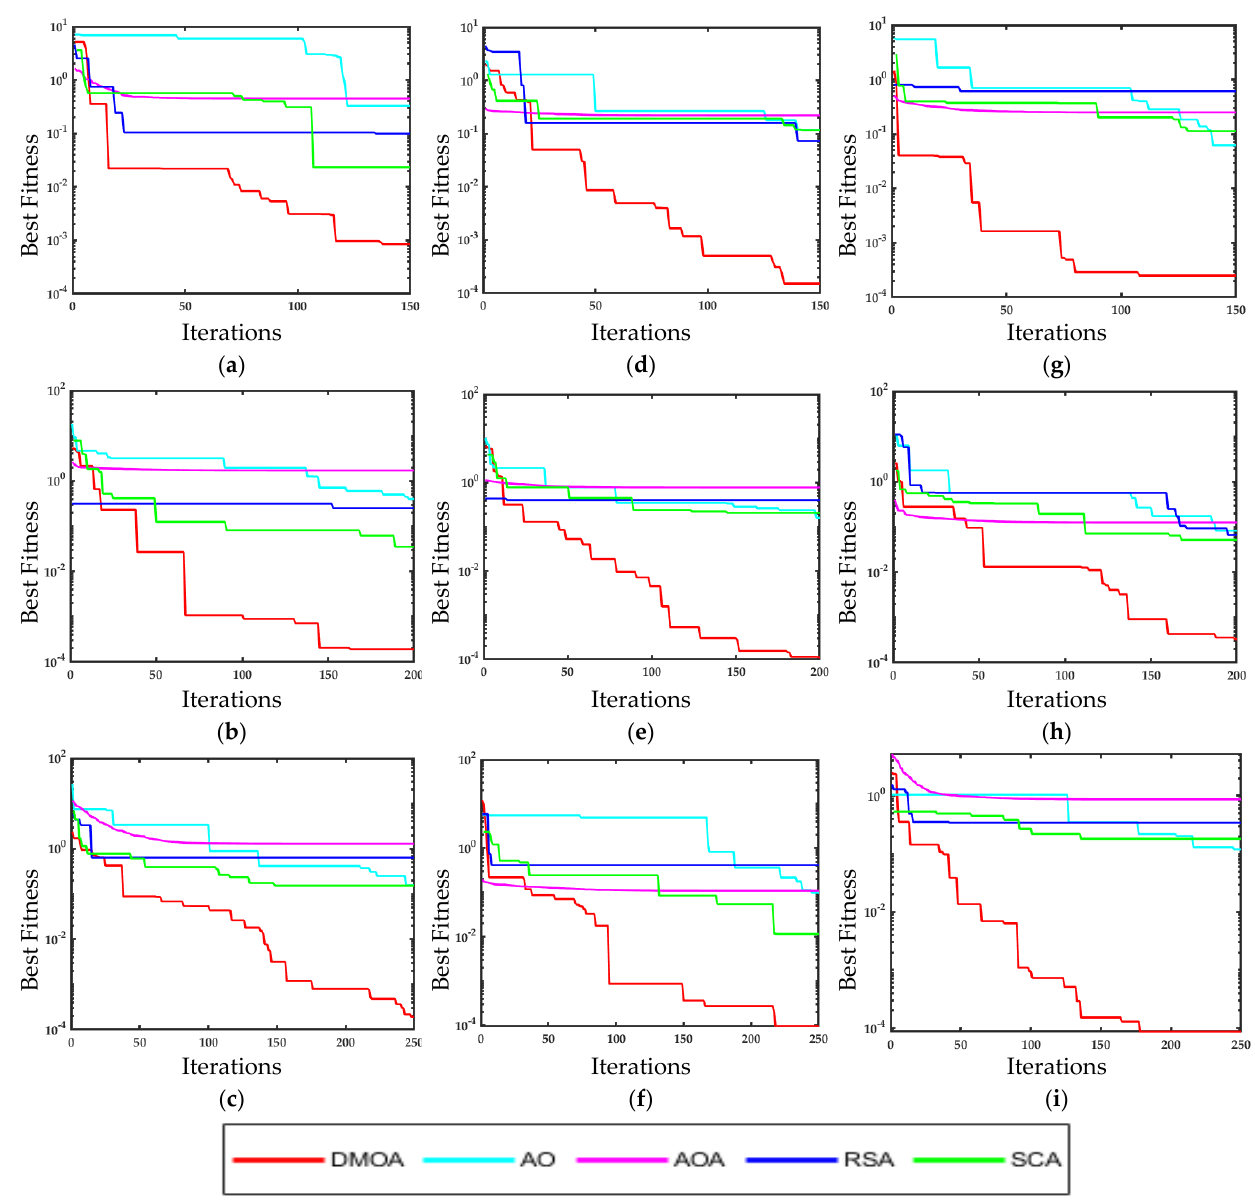
Figure 5. Fitness plot comparison of the DMOA with the AO, AOA, RSA and SCA w.r.t population size. ( a – c ) Np = 15 ( d – f ) Np = 20 ( g – i ) Np = 25.